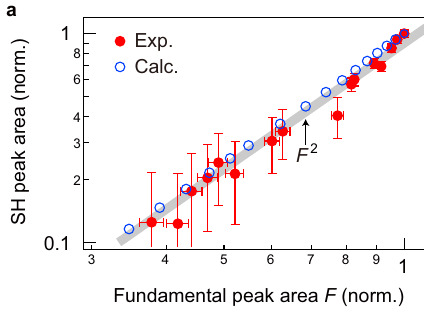
Fig.5|Dependenceofthehigherharmonicpeakareaonthefundamentalpeak area. a , b Normalized dependence of the SH ( a ) and TH peak area ( b ) on the fun- damental peak area F . The data points for the experiment (solid circles) and calcu- lation (open circles) are the peak areas obtained by integrating the corresponding